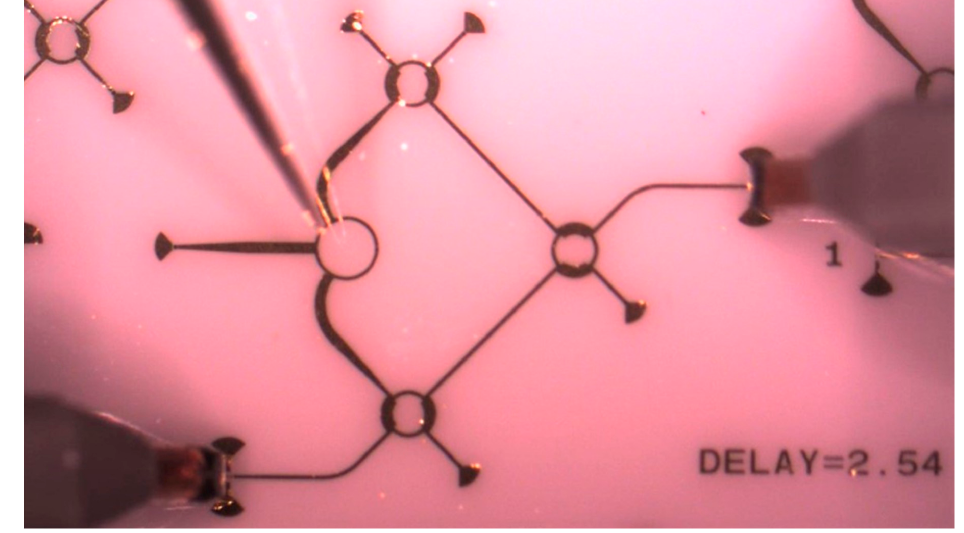
Figure 32. Multi-port under measurements (S 36 ).